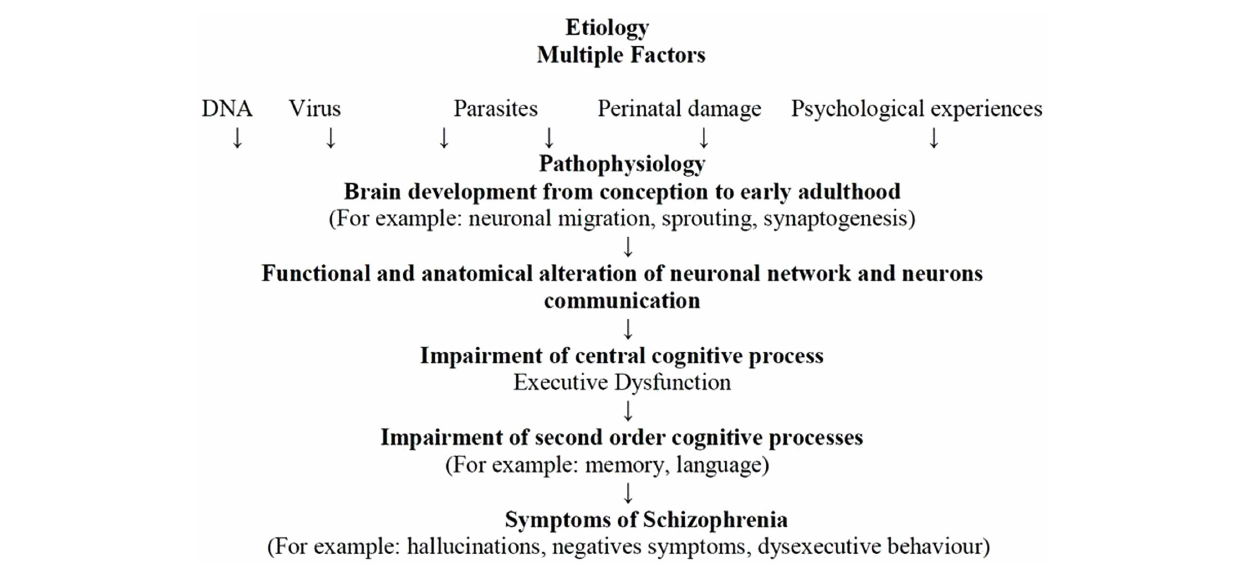
FIGURE 3 |TheAndreasen model adapted fromAndreasen (2000)